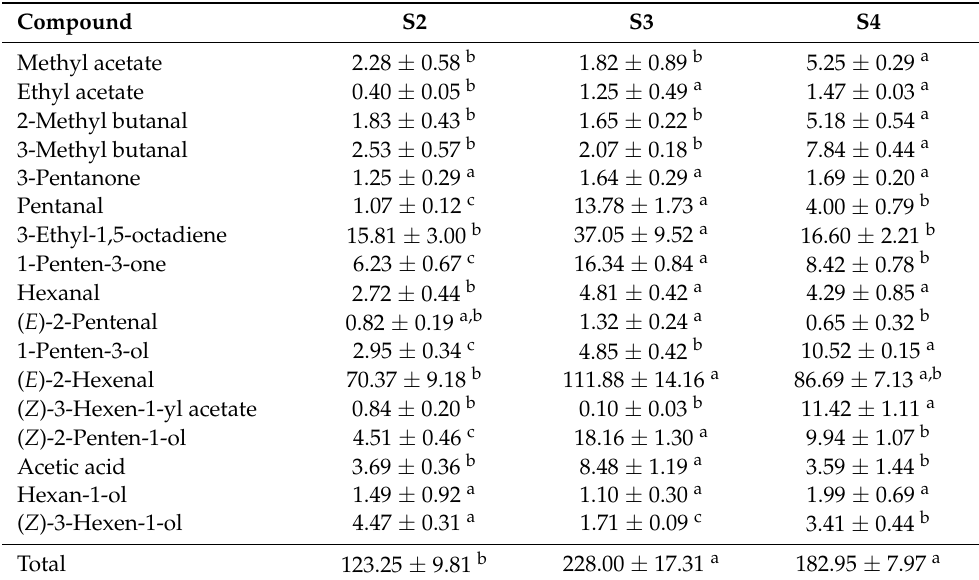
Table 5. Identified volatile compounds (mg OE kg − 1 ) of the Oliva Rossa VOOs extracted during fruit ripening in the 2017/2018 harvest season (mean ± SD, n =